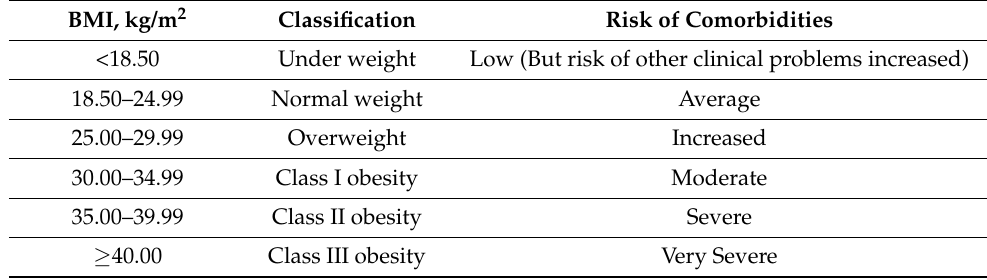
Table 1. Body Mass Index